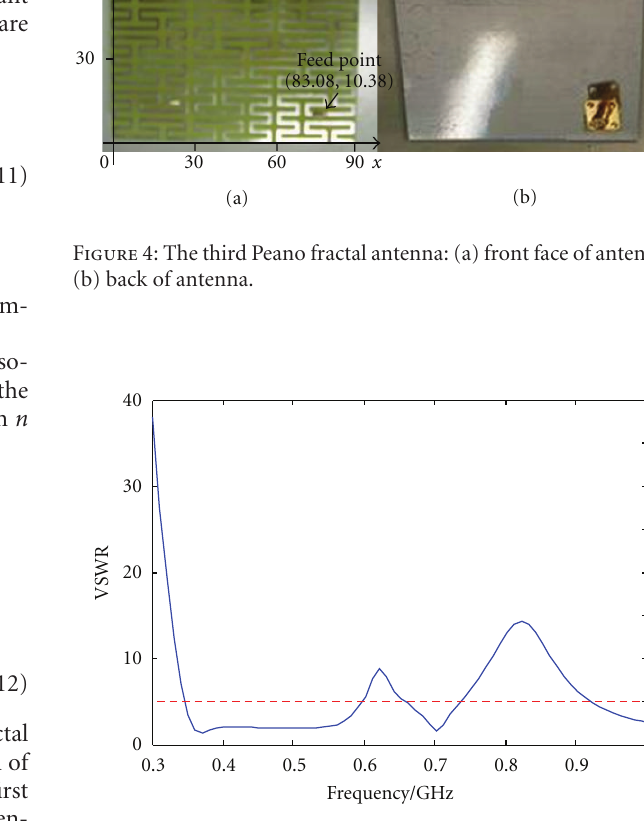
Figure 5: VWSR curve of the Peano fractal